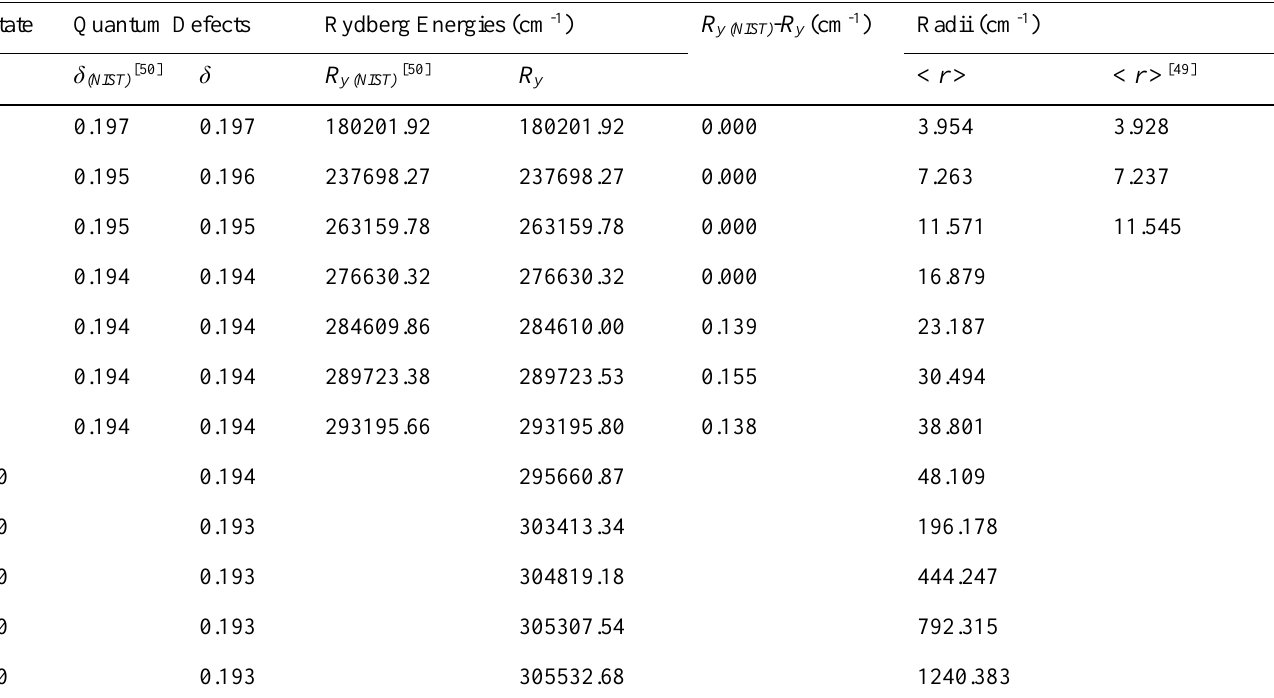
Spectral Rydberg Energy Series with Quantum Defects and Radii of Li iso-electronic sequence in 1 s 2 ns 2 S e 1/2 (B III)